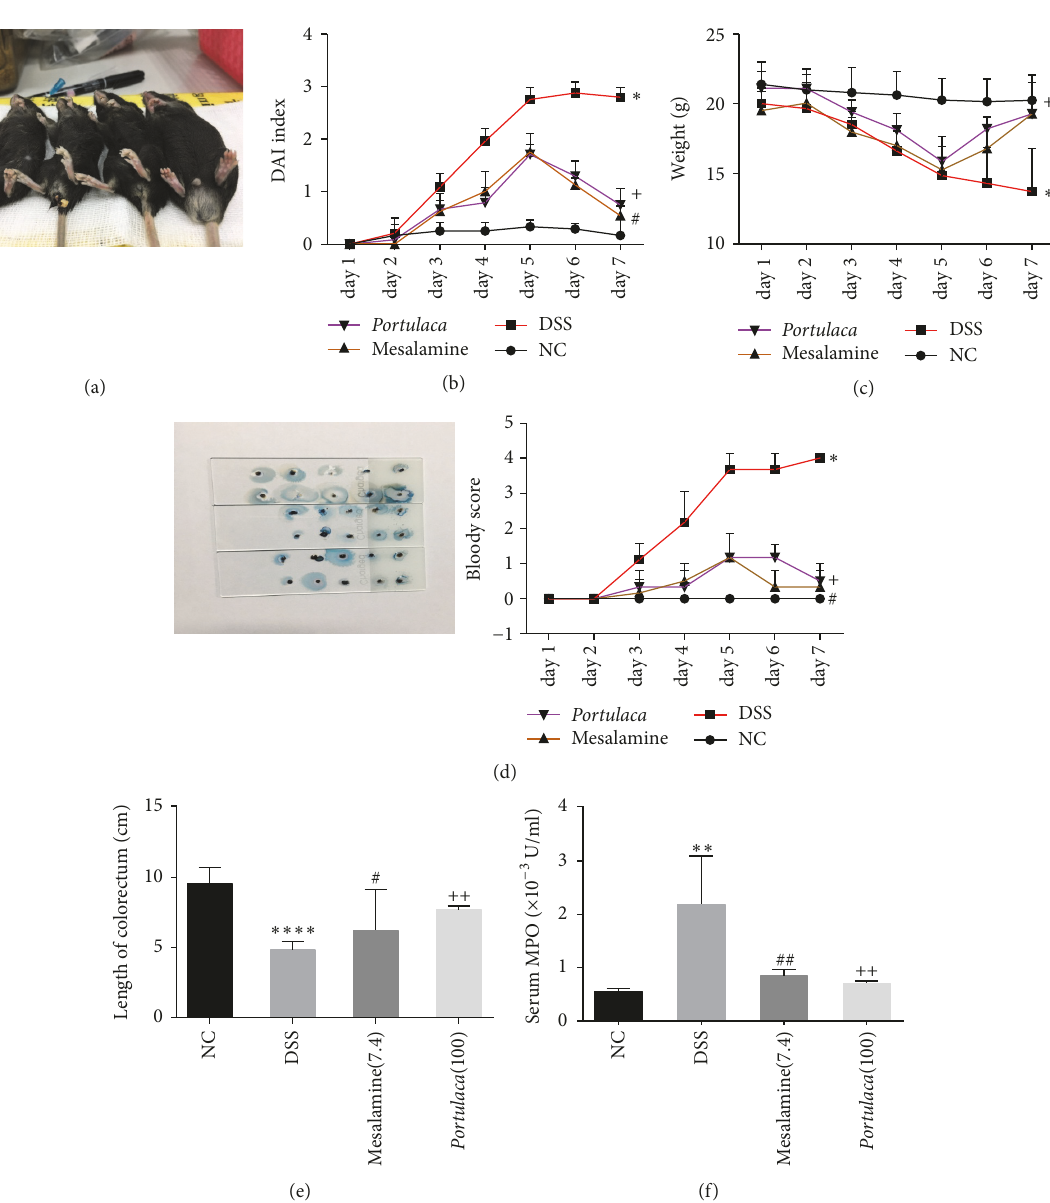
Figure 1: Effect of Portulaca treatment on disease severity of DSS-induced UC model. Panel (a) shows the appearance of representative mice from four experiment groups from left to right: control group, DSS-induced group, mesalamine group, and Portulaca group. Panel (b) displays the graph of disease activity index (DAI) of four groups at different days of the experiment. Panel (c) represents the weight of mice daily in different group. Panel (d) shows the image of fecal occult blood testing at 8th day with the darker color and more severe bloody stool and shows the score of bloody stool at different days of each group. Panel (e) represents the length of colorectum from four groups at 8th day after DSS administration. Panel (f) indicates the MPO activity in serum. (Data were presented as mean ± SD from six rats. ∗ indicates comparison between DSS and NC; # indicates comparison between mesalamine and DSS; + indicates the comparison between Portulaca and DSS. The number of symbols indicates significance of difference; for example, four symbols indicate 𝑝 < 0.0001 ; three symbols indicate 𝑝 < 0.001 ; two symbols indicate 𝑝 < 0.01 ; and one symbol indicates 𝑝 < 0.05